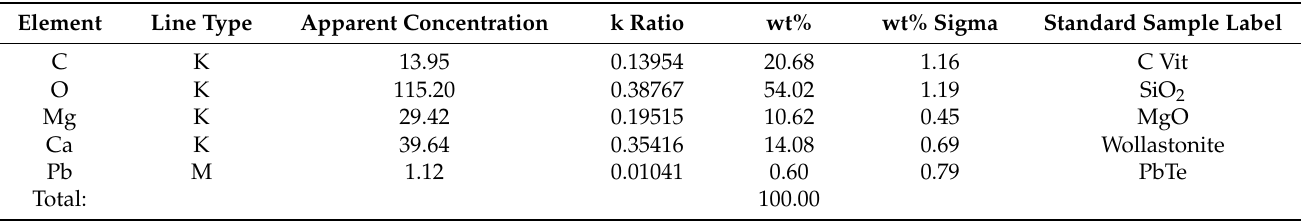
Table 2. EDS spectra of dolomite surfaces after exposure to 50 mL of 1 mg/L PbCl 2 solution for 15 days.